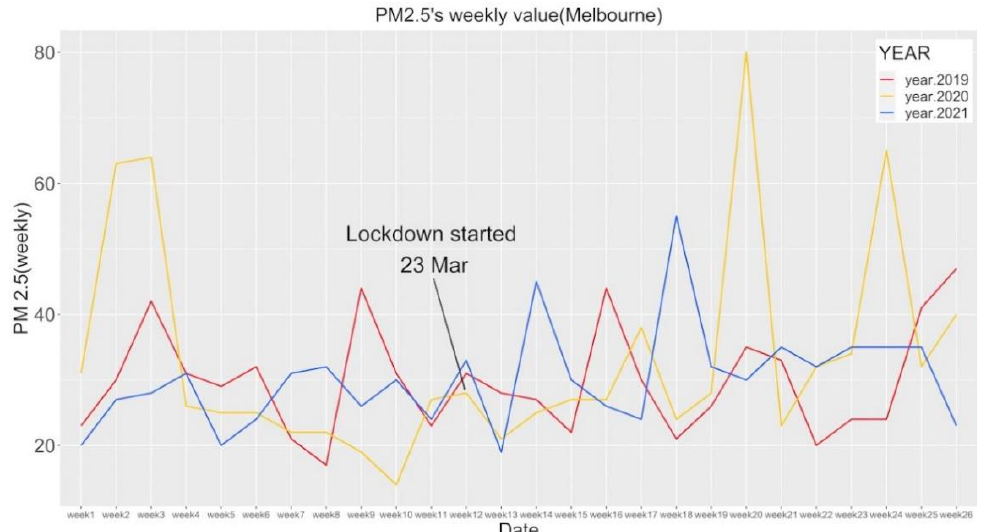
Figure 3. Weekly PM2.5 value (Seoul).